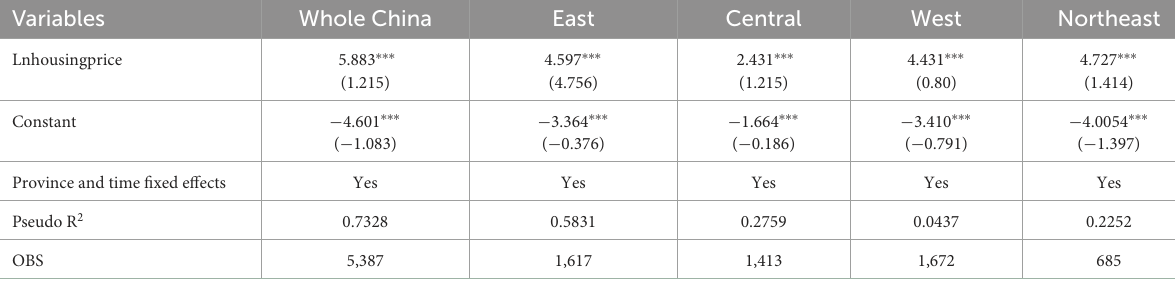
TABLE 3 Results of the impact of housing price on short-term economic development.